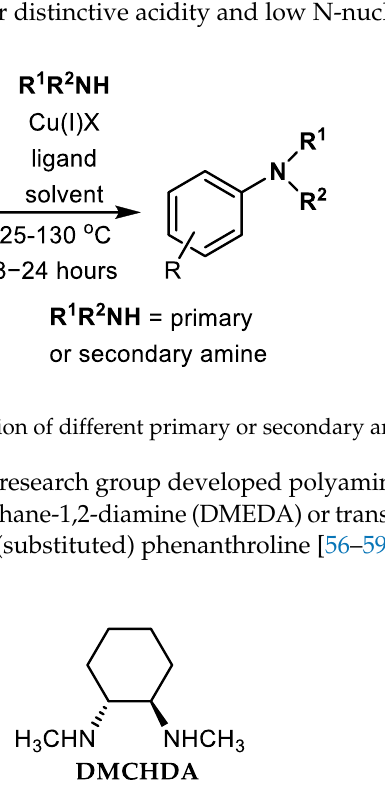
Figure 4. Structures of highly active 1,3-diketone-based ligands [69 – 71].